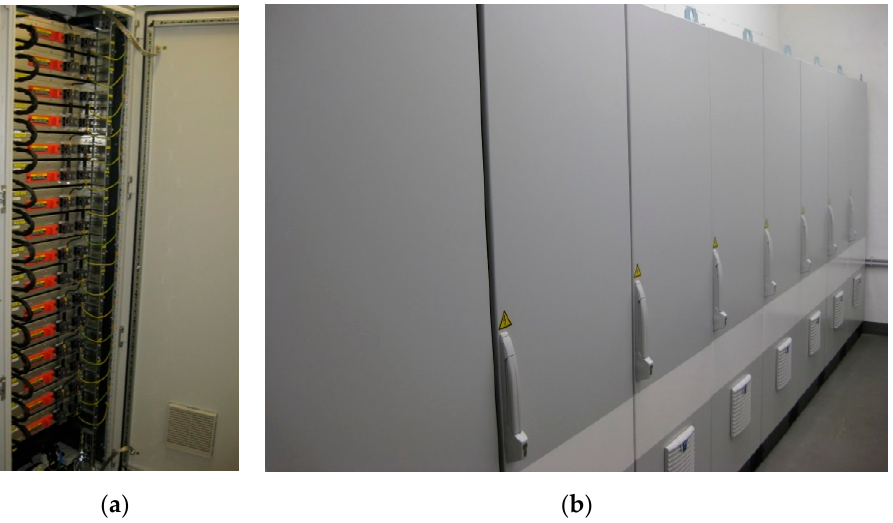
Table 2. Specification energy storage module.